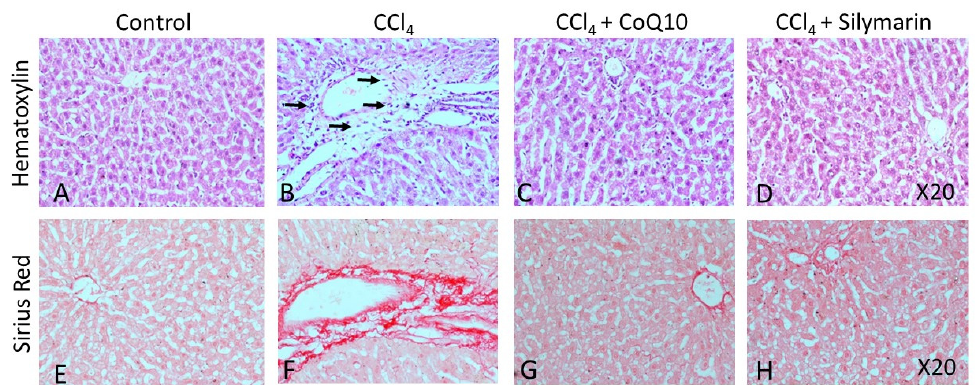
Figure 5. Effect of CCl 4 and supplementation with CoQ10 and silymarin on liver tissue. Hemtoxylin-eosin staining shows the cellular morphology in control ( A ), CCl 4 ( B ), CCl 4 + CoQ10 ( C ), and CCl 4 + silymarin ( D ) liver of ovariectomized rats. Arrows indicate infiltrating cells. Sirius Red staining depicts fibrosis in control ( E ), CCl 4 ( F ), CCl 4 + CoQ10 ( G ), and CCl 4 + silymarin ( H ) liver of ovariectomized rats. 20× magnification.